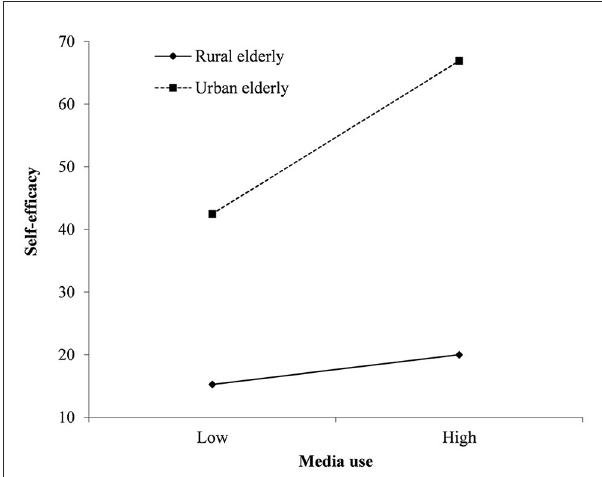
FIGURE2 The moderating effect of urban-rural residency on the relationships between media use with self-efficacy.